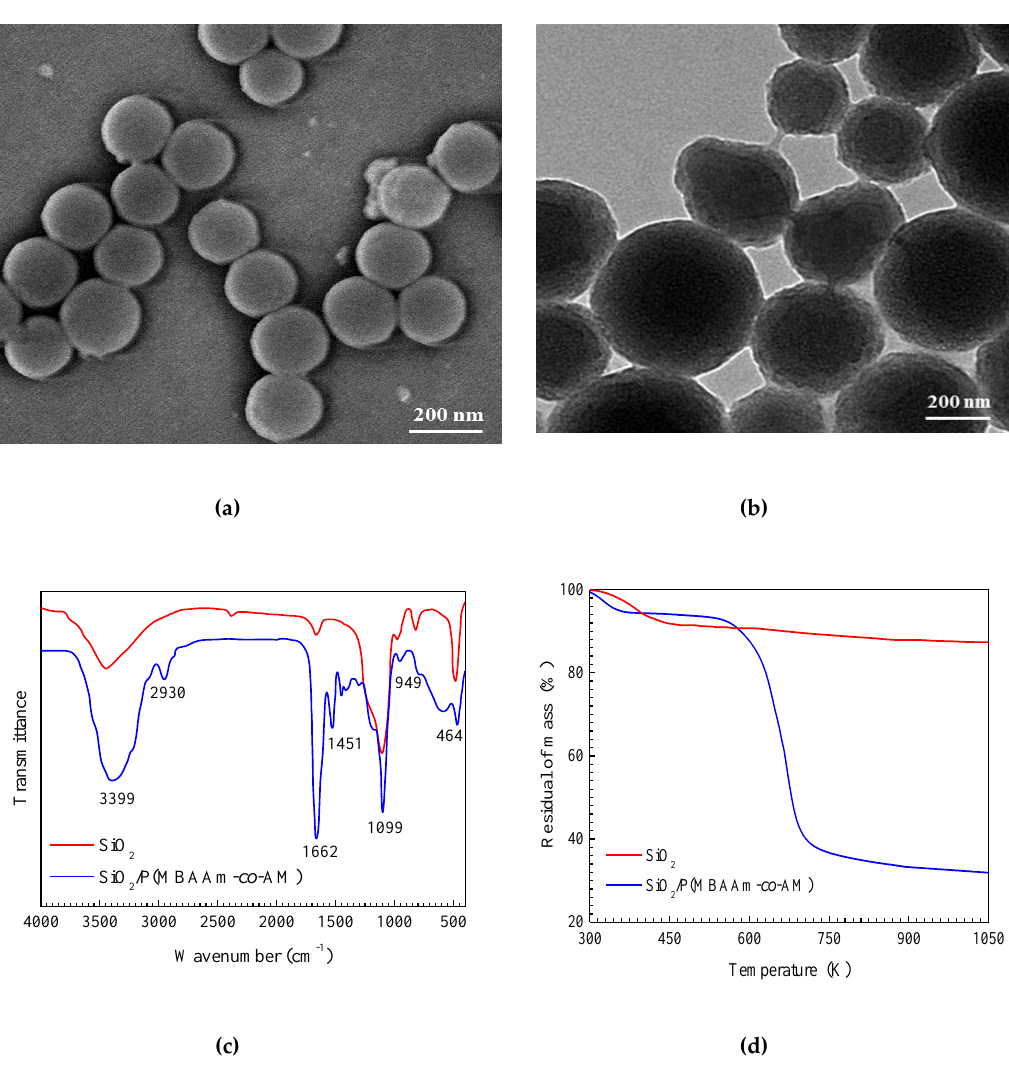
Figure 3. SEM image of SiO 2 nanoparticles ( a ); TEM image of SiO 2 / P(MBAAm- co -AM) nanoparticles ( b ); and FT-IR spectra ( c ) and TGA curves ( d ) of SiO 2 , SiO 2 / P(MBAAm- co -AM).